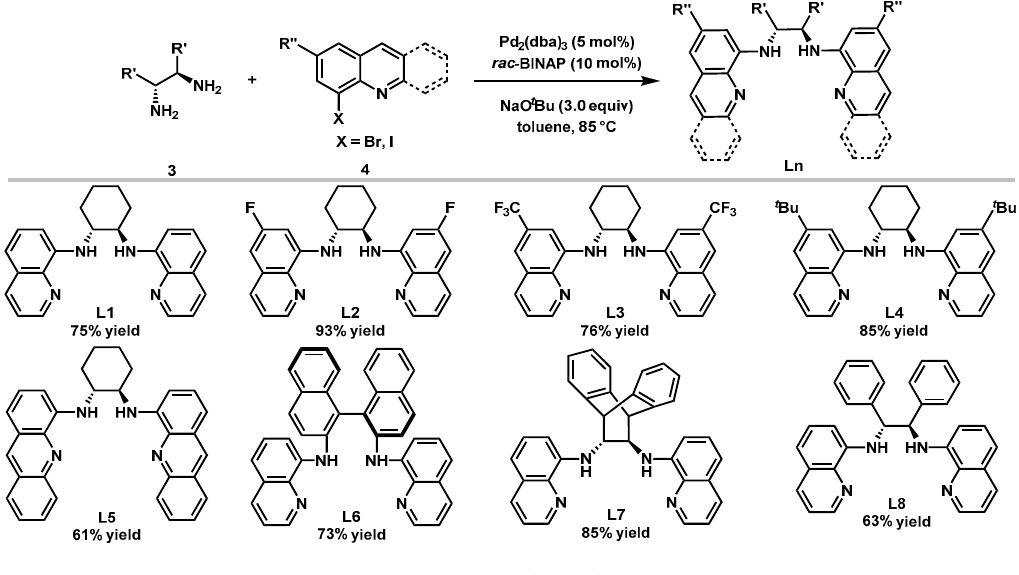
Figure 3 . Ligands synthesis. Figure 3. Ligands